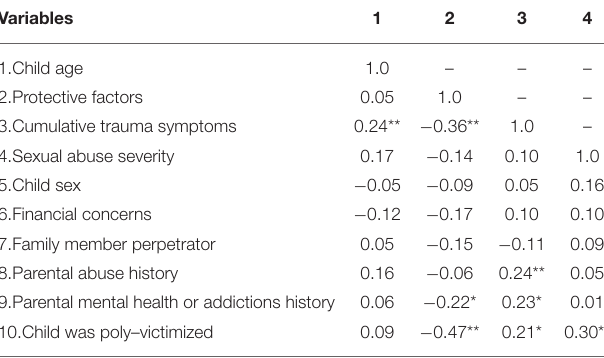
TABLE 2 | Pearson and point-biserial correlations among study